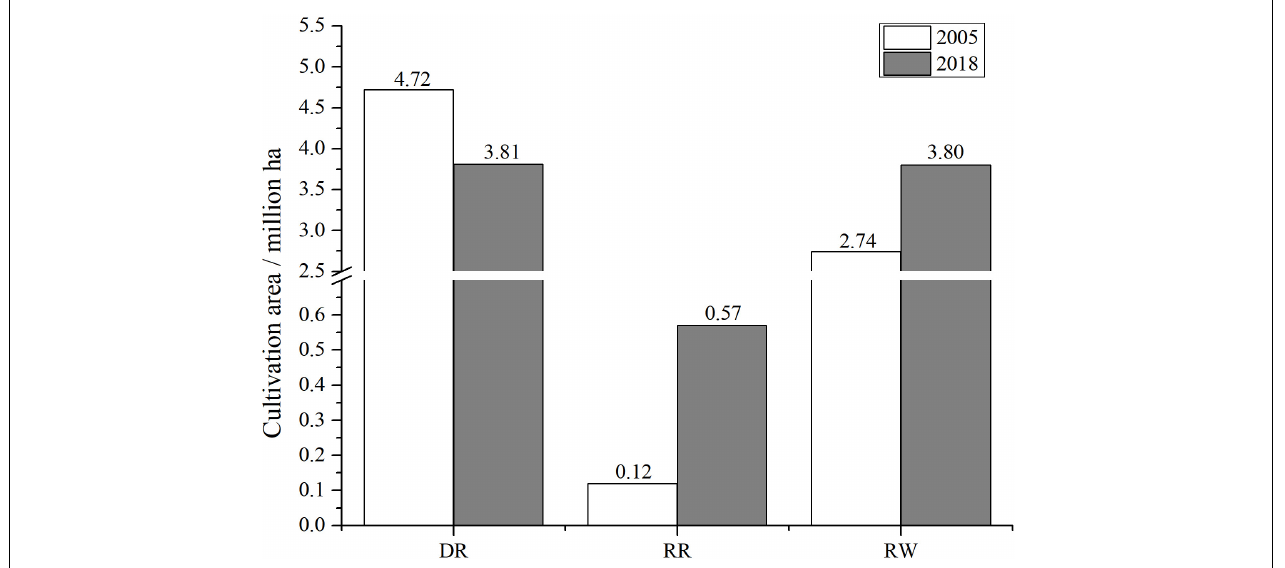
FIGURE 2 | Shift of cultivation area for the three rice cropping systems in central China. DR, double-rice system; RR, ratoon rice system; RW, rice-wheat system; the original data came from Agricultural Technology Extension Station of Hubei, China. TABLE 4 | Grain yield, carbon, nitrogen, and water footprints of the three cropping systems. Year Treatment Grain yield (t/ha) Carbon footprint (kg CO 2 -eq/t) Nitrogen footprint (kg N-eq/t) Water footprint (m 3